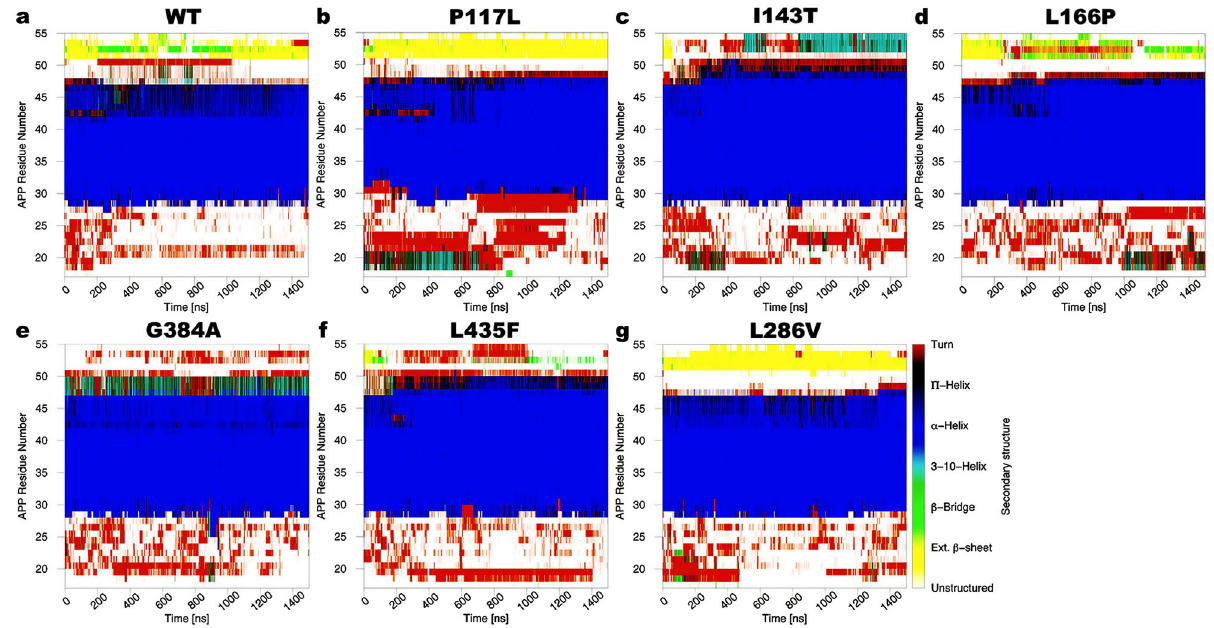
Fig. 5 Time-dependent secondary structures of APP bound to γ -secretase calculated from the GaMD simulations. Time courses of the APP secondary structures in the ( a ) WT (Sim1), ( b ) P117L (Sim1), ( c ) I143T (Sim1), ( d ) L166P (Sim2), ( e ) G384A (Sim3), ( f ) L435F (Sim1) and ( g ) L286V (Sim1) PS1 FAD mutant γ -secretase calculated from representative GaMD simulations. Results from other simulations are plotted in Supplementary Figs. 10 –